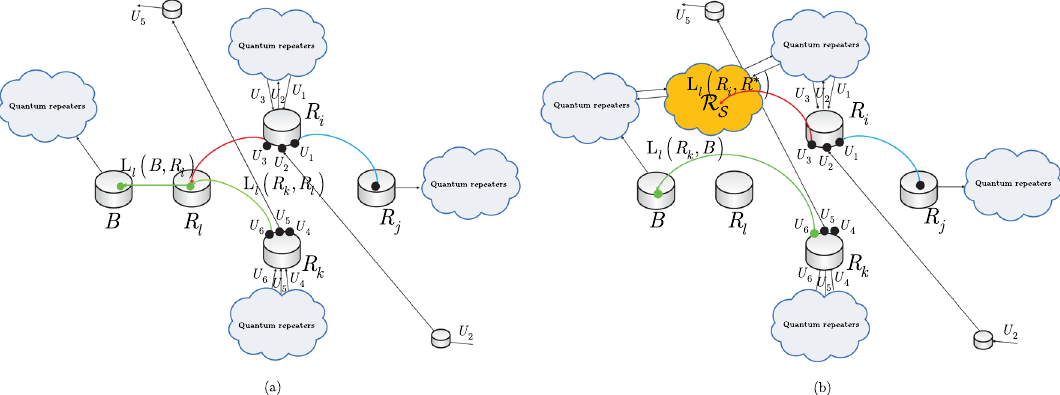
Figure 3. Entanglement distribution with resource balancing in the quantum Internet. ( a ) Low-priority quantum repeaters. Users U 3 and U 6 would like to share an entangled connection with B through R l .